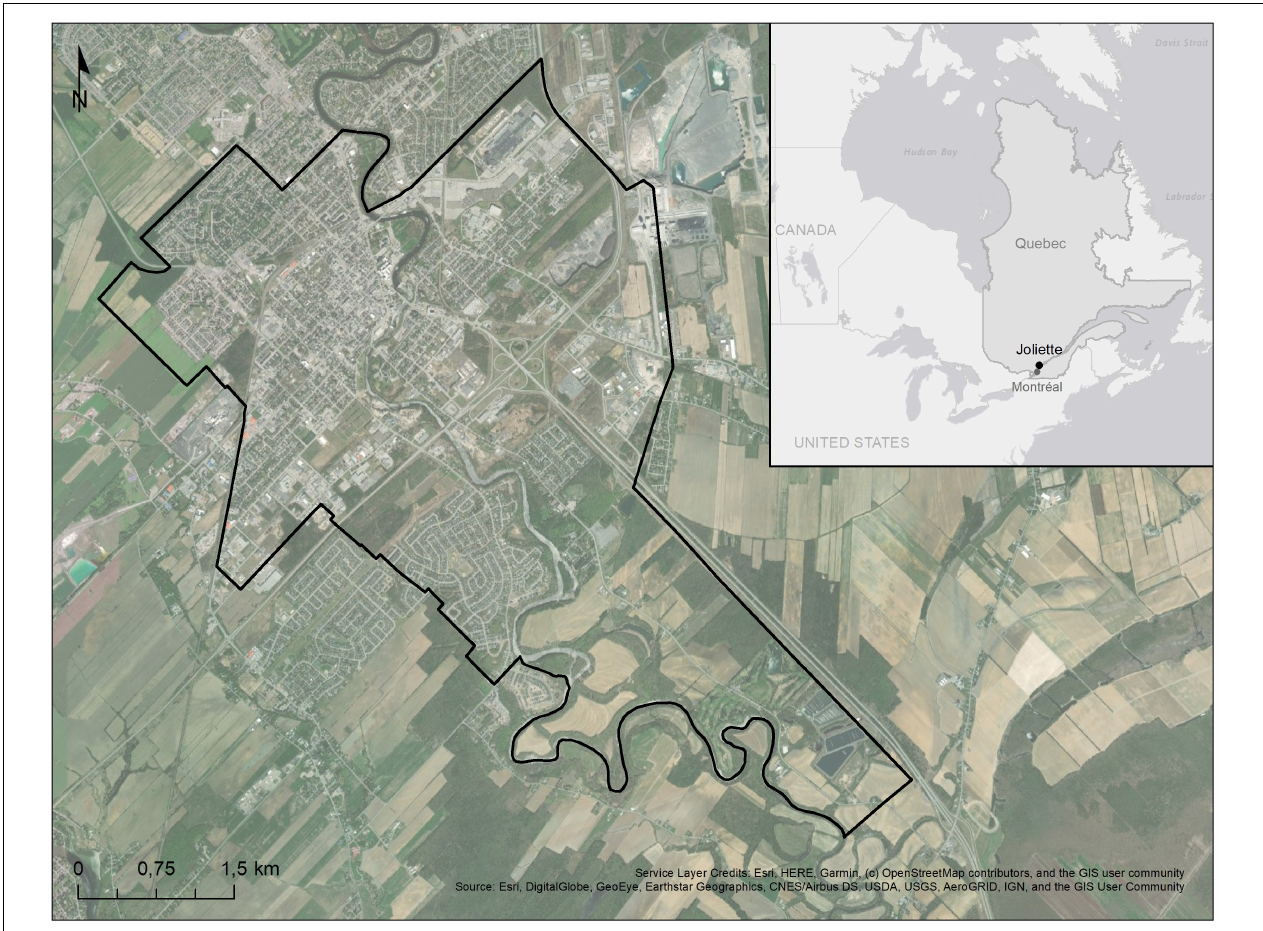
FIGURE 1 | Map of the City of Joliette. The inset map shows the location of the study area in Quebec and Canada. Maps were created using ArcGIS software (version 10.7.1;